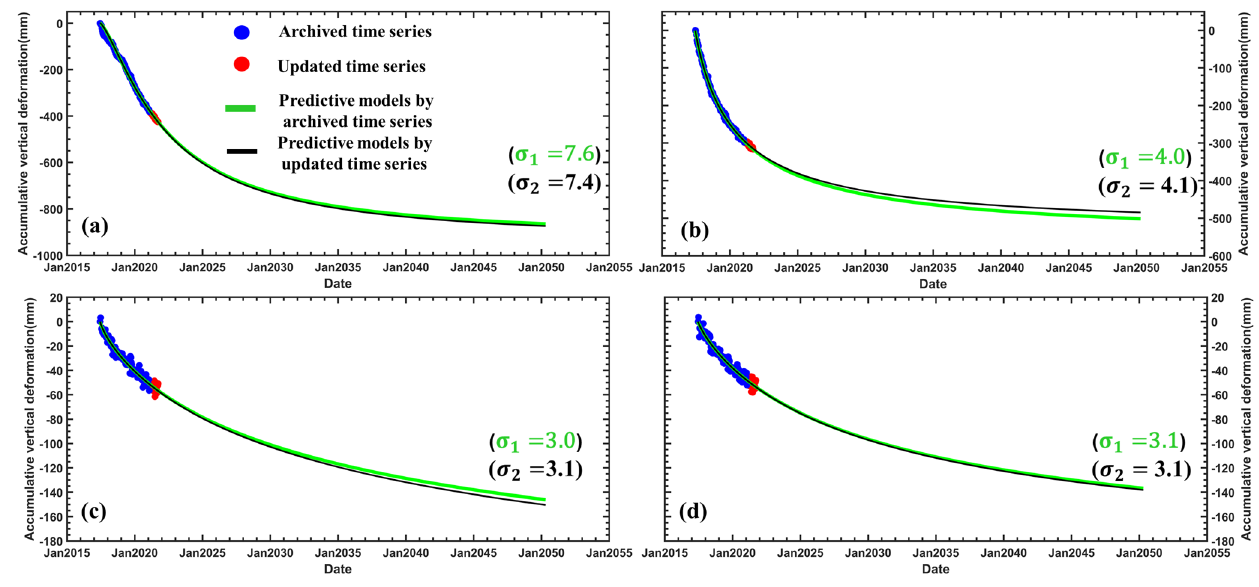
Figure 9. The geotechnical model predicted vertical deformation time series at four points S1 to S4 ( a – d ), whose positions are marked in Figure 8b.